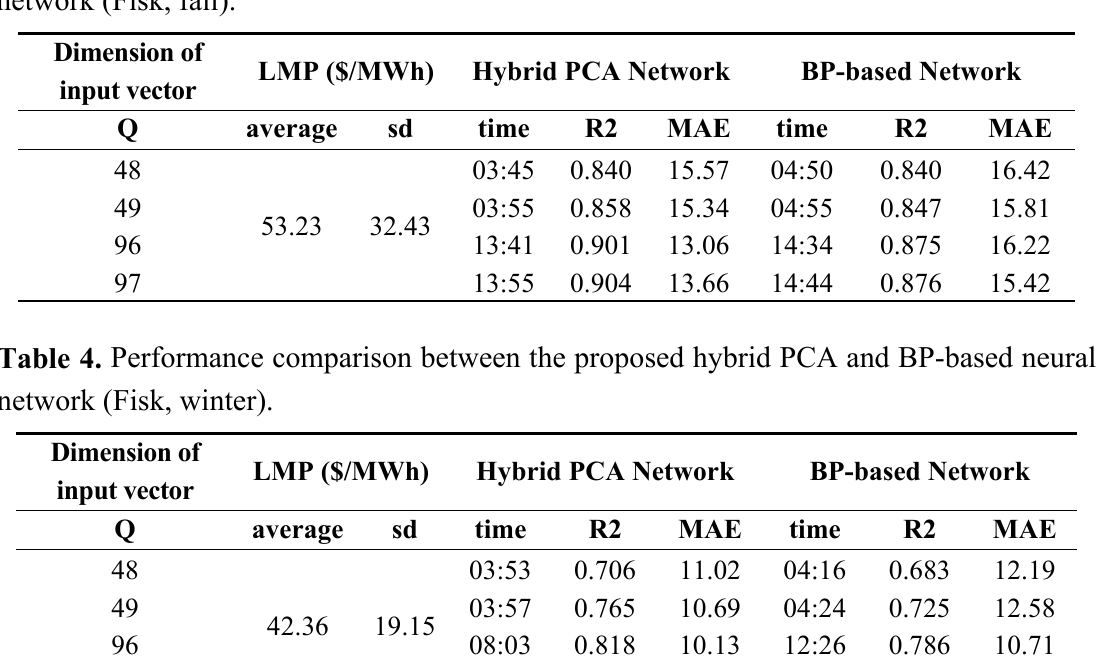
Table 3. Performance comparison between the proposed hybrid PCA and BP-based neural network (Fisk, fall).